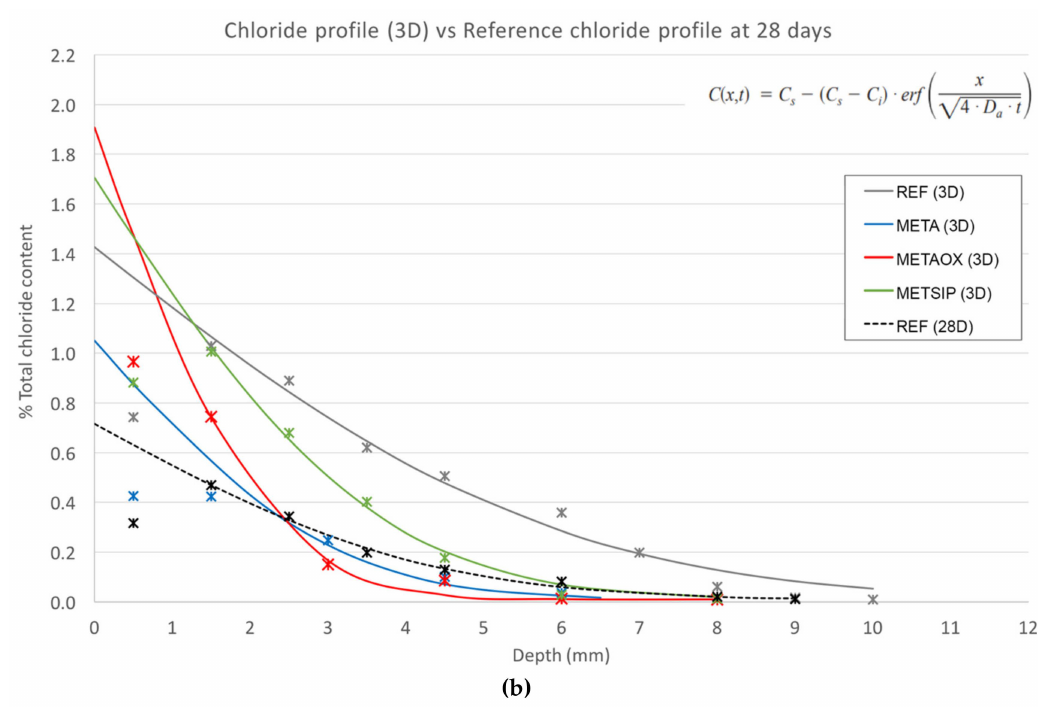
Figure 5. Chloride profiles at ( a ) two days and ( b ) three days for all samples and for reference mortar at 28 days.